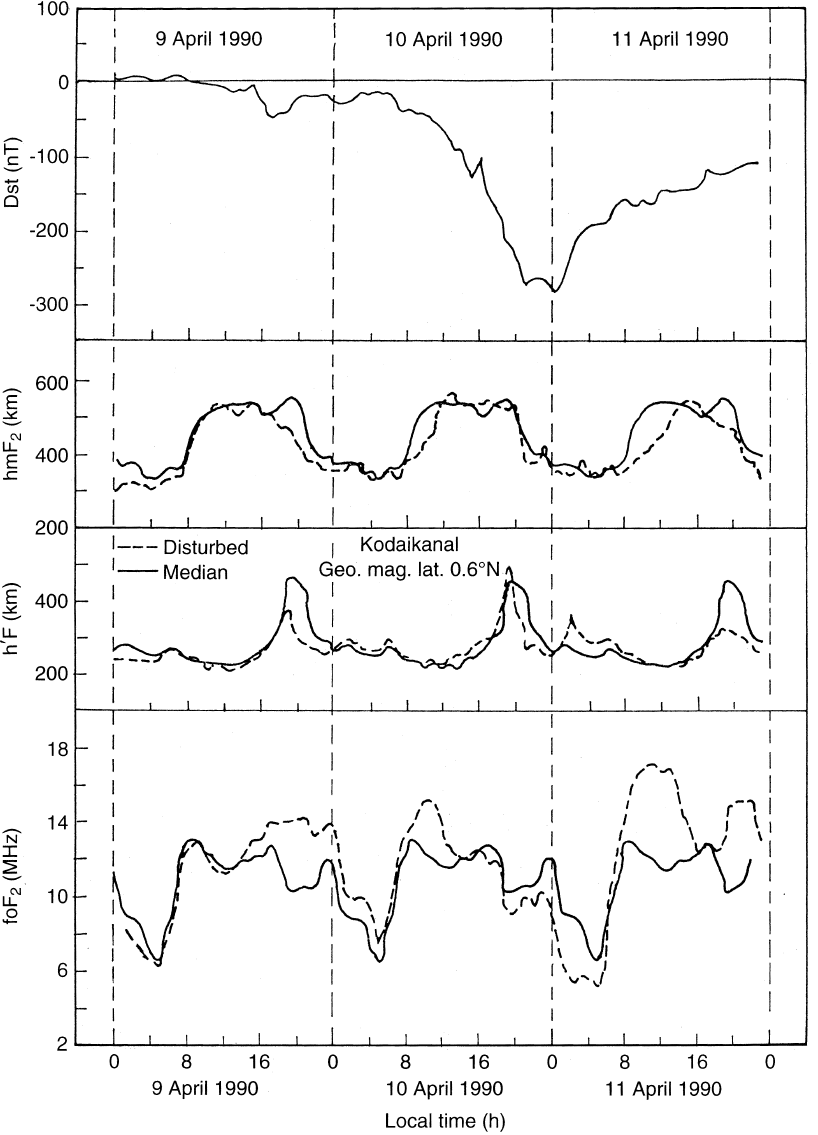
Fig. 2. Shows foF2, h ¢ F and hmF2 data for Kodaikanal for the 9 April 1990 storm along with respective monthly median values. Dst variation for the storm period is shown in the top